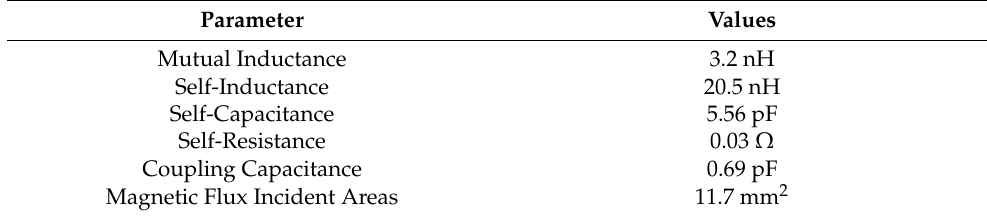
Figure 13. Double pulse test set: ( a ) Gerber file of the daughter board containing the pickup coil, ( b ) overall test board, and ( c ) double pulse test circuit (DPT). Table 6. Circuit parameters of the current sensor.